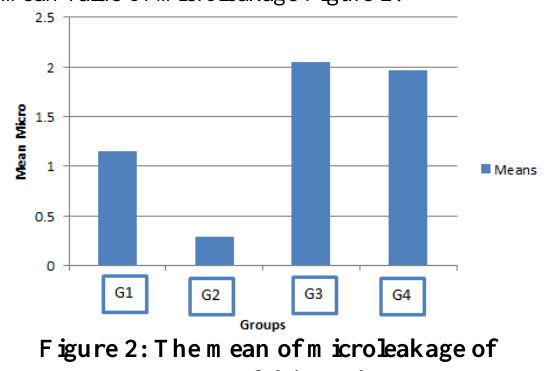
Figure 2: The mean of microleakage of groups of this study.